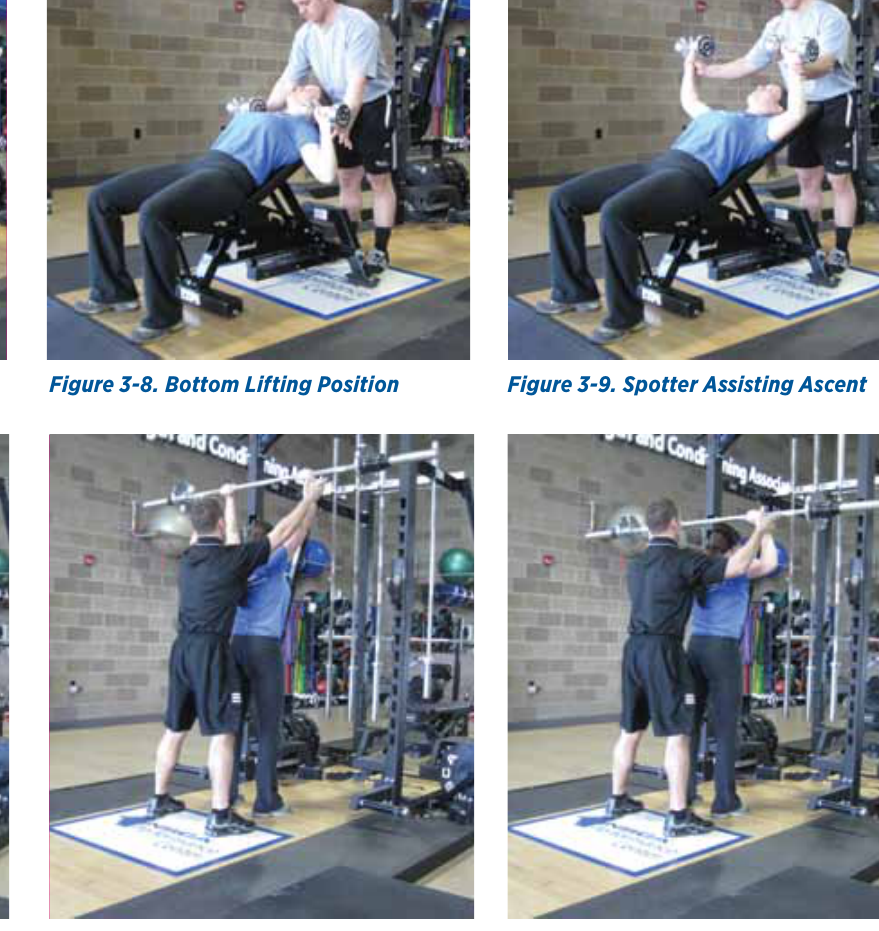
Figure 3-11. Highest Position Figure 3-12. Spotter Assisting